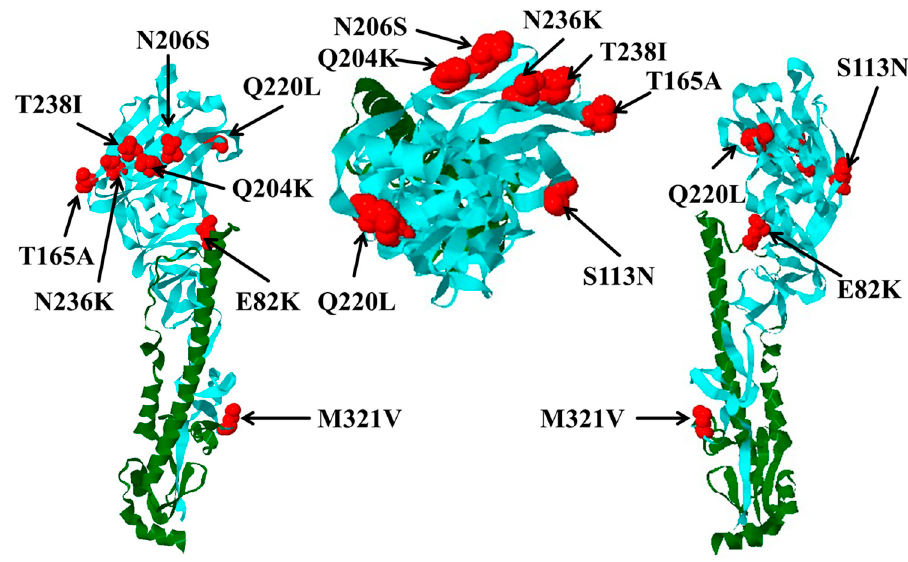
Figure 1. Locations of hemagglutinin 1 (HA1) mutations and their impact on receptor binding activity and cleavability of hemagglutinin. Predicted locations of HA mutations in seal H10N7 viruses compared to avian H10Nx viruses are shown in red. HA1 is shown in cyan and HA2 in green. Left and right views are about 180 degrees apart (e.g., front vs. back views), and head view is in the middle.